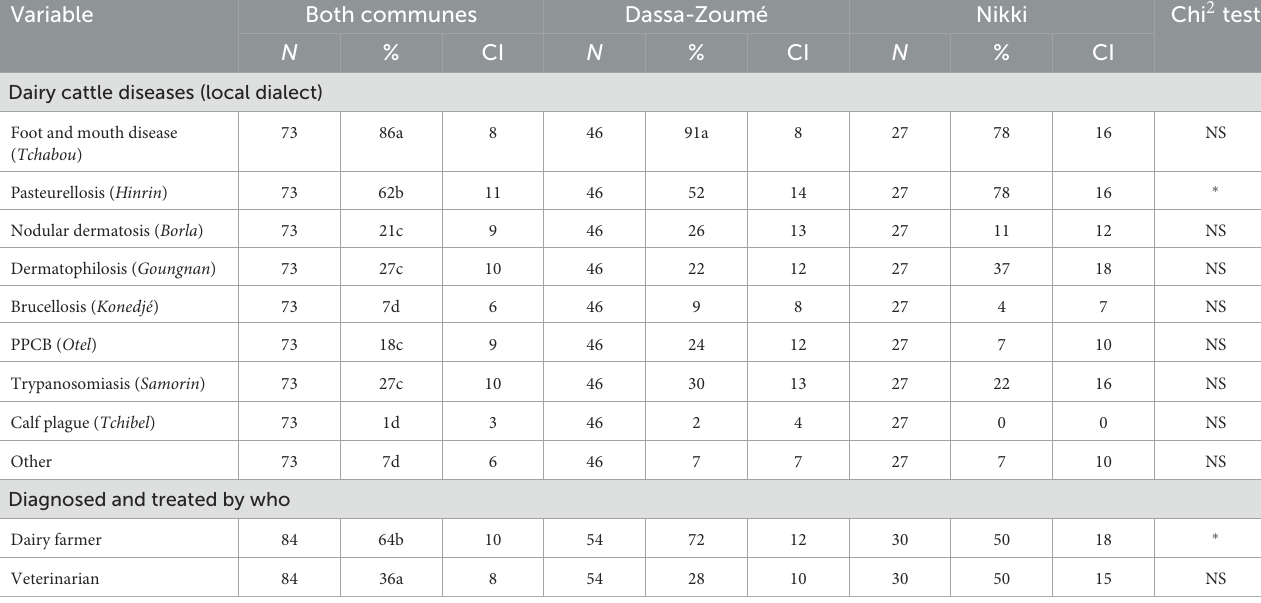
TABLE 2 Dominant diseases identified in farm animals and disease diagnosis in the communes of Dassa-Zoumé and Nikki. Variable Both communes Dassa-Zoumé Nikki Chi 2 test N % CI N % CI N % CI Dairy cattle diseases (local dialect) Foot and mouth disease 73 86a ( Tchabou ) Pasteurellosis ( Hinrin )